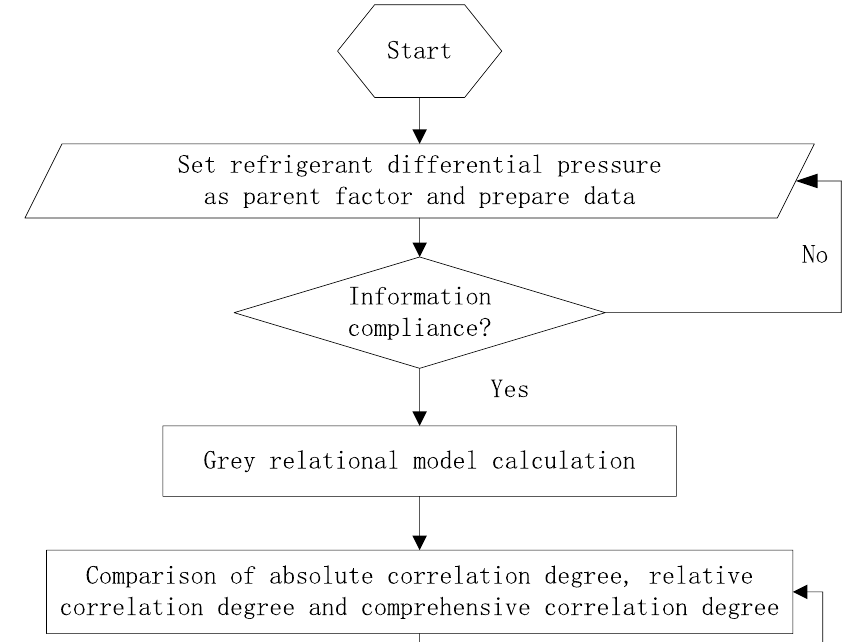
Fig. 2 Logic diagram of calcu- lation